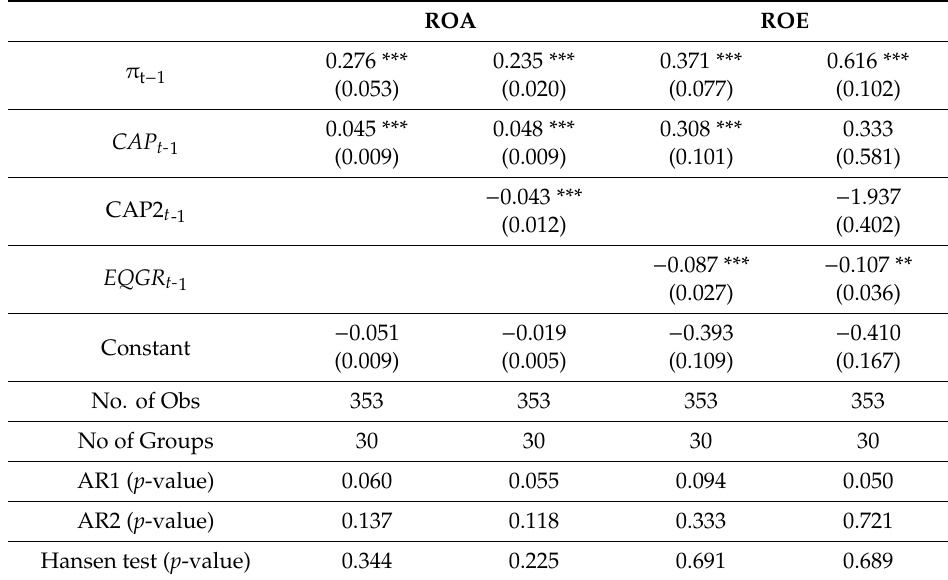
Table 11. The relationship between the capital ratio and bank profitability using system